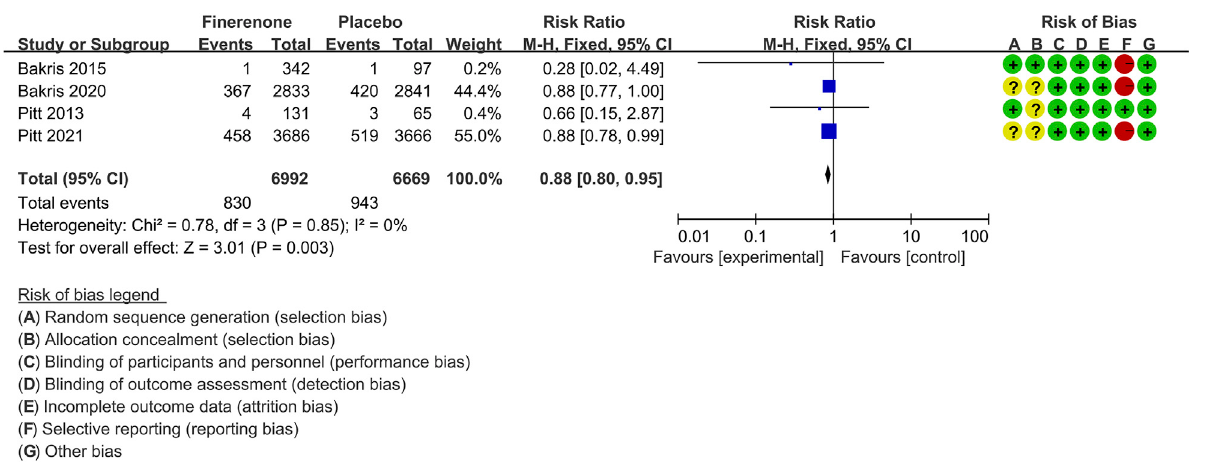
Frontiers in Pharmacology |